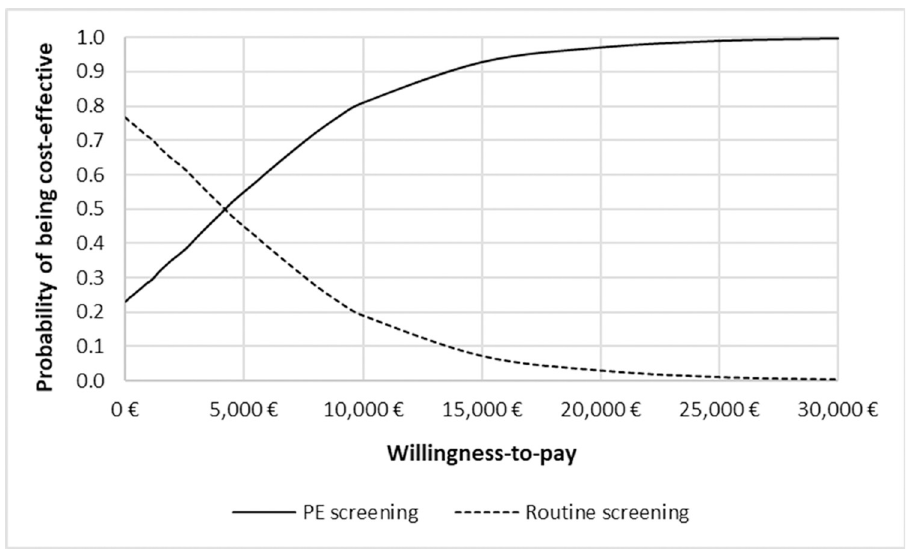
Fig 6. Cost-effectiveness acceptability curve for Germany.